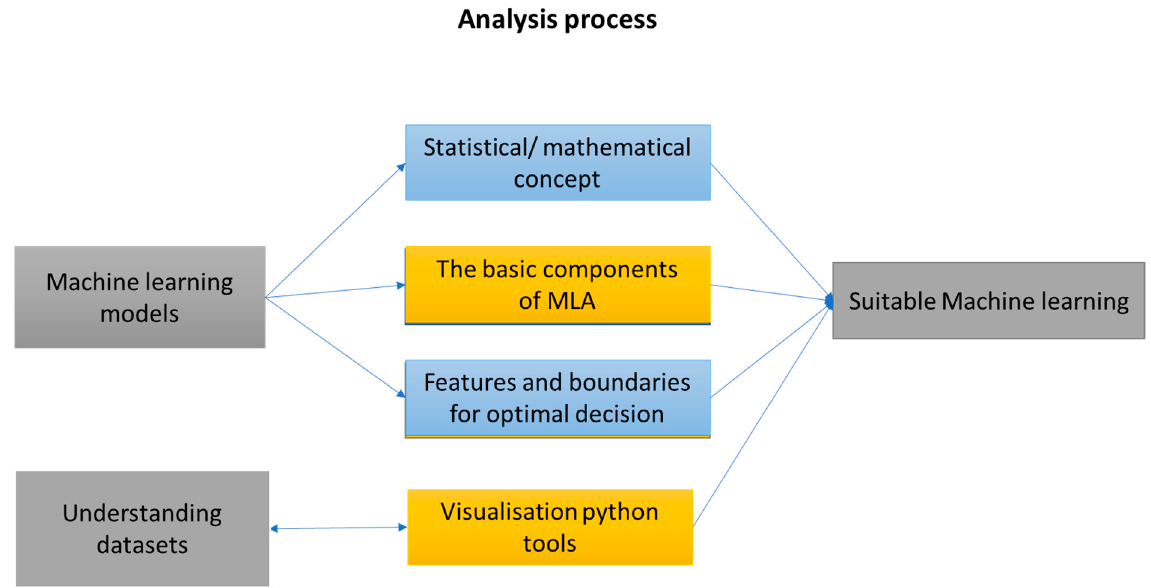
Figure 2. The analysis process of this